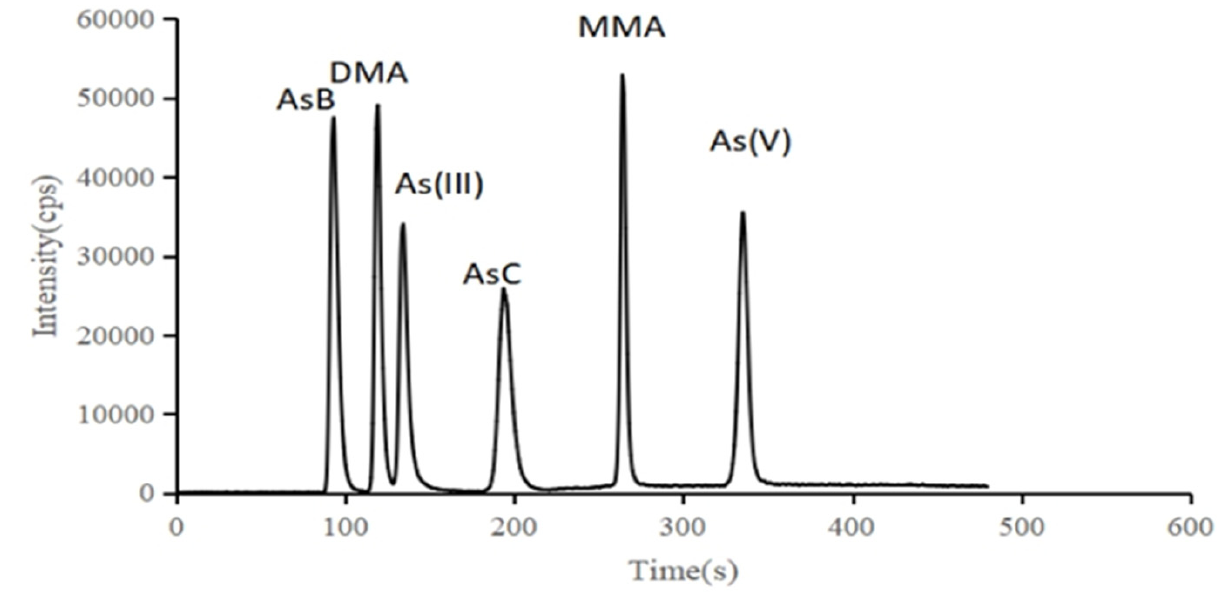
Figure 1. Standard chromatogram (10 µ g L − 1 ). Table 1. Accuracy and repeatability of the method for evaluating total As. Total As content is expressed as As µ g kg − 1 dry mass (mean ± SD, n =